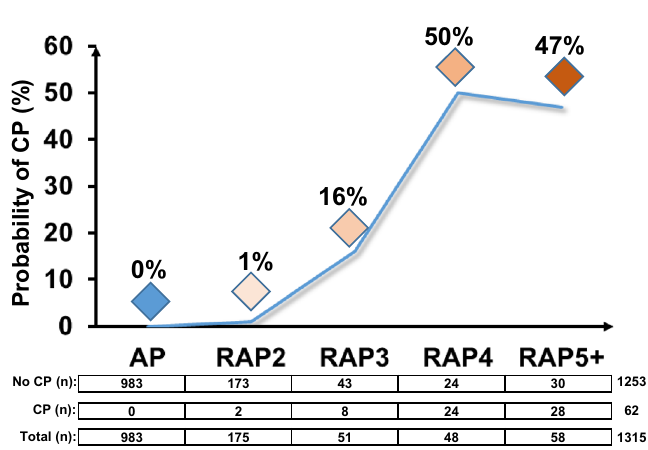
Figure 5. Progression from the first acute pancreatitis (AP) episode through recurrent episodes (RAP) towards chronic pancreatitis